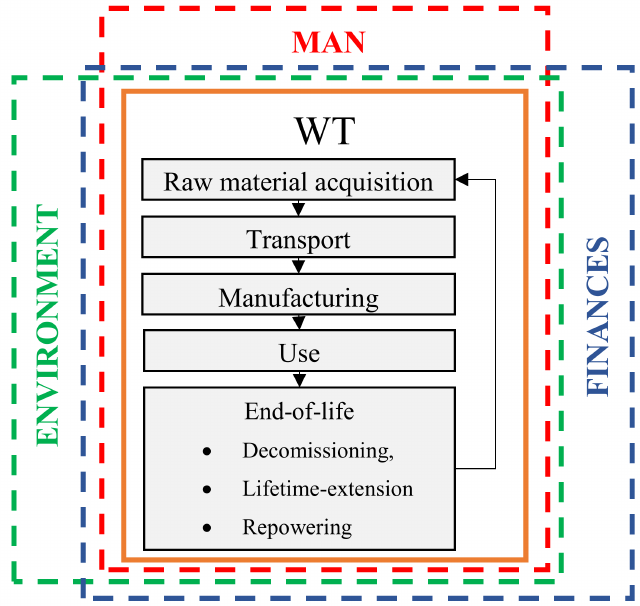
Figure 1. Spaces in sustainable lifecycle management, WT—wind